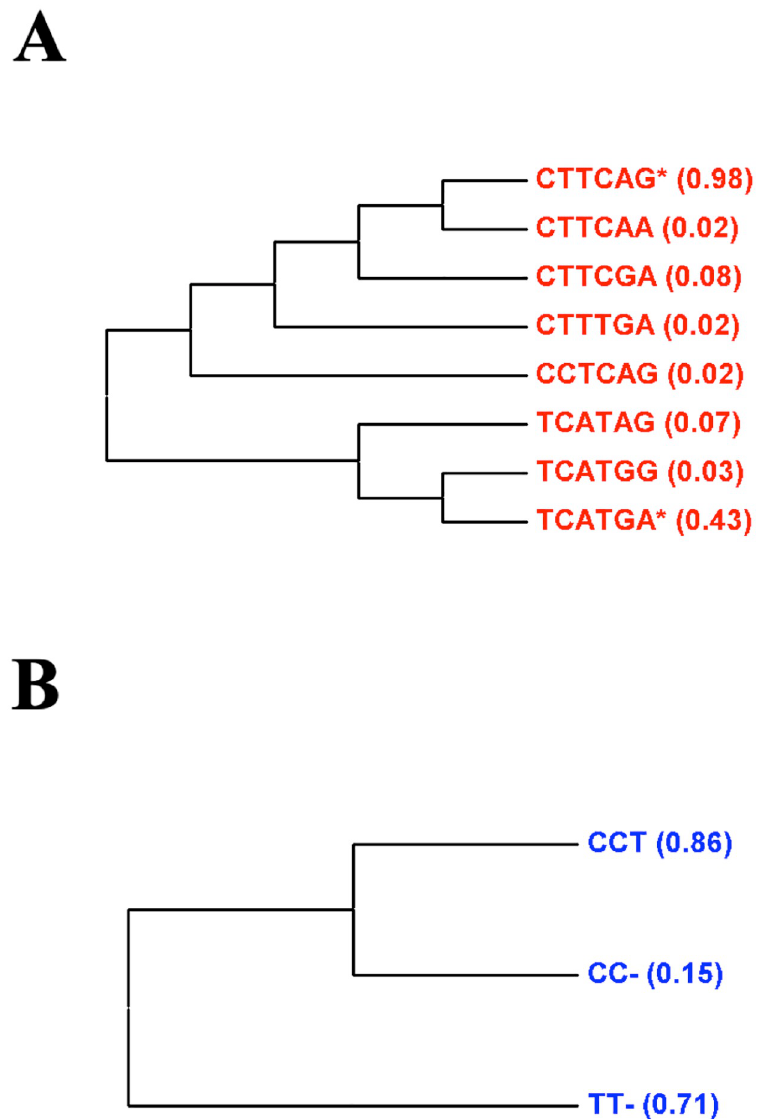
Fig 2. Haplotypes of nucleotides found in biallelic polymorphic positions at chromosomal loci CHR24/3074 and CHR28/425451 of at least two different isolates in the collection of L . braziliensis used in the study. For each locus , DNA sequences of four to six clones per L . braziliensis isolate of the study collection (i.e. primary plus validation samples) were aligned using MEGA X. Multiple alignment across all study isolates permitted identify polymorphic nucleotides at biallelic positions 31, 52, 68, 129, 469 and 604 in locus CHR24/3074, and 30, 286 and 545 in CHR28/ 425451. (A) Haplotypes of nucleotides detected within polymorphic positions at CHR24/3074; (B) Haplotypes of polymorphic nucleotides detected in CHR28/425451. The proportional representation of each haplotype in the sample is within parenthesis at the tips of the dendrograms.